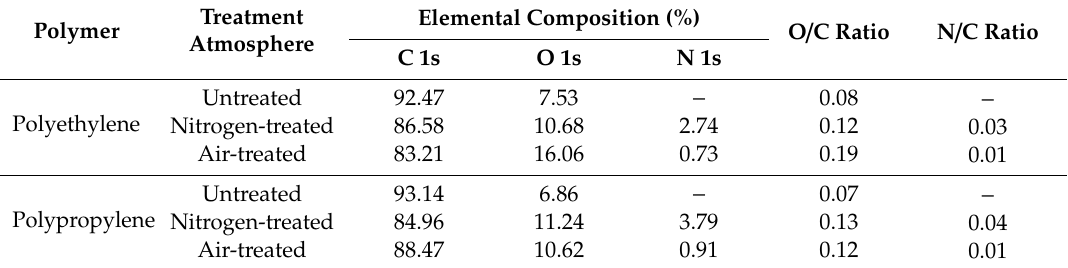
Table 1. Elemental composition (atomic %) of untreated and treated PE and PP surfaces.